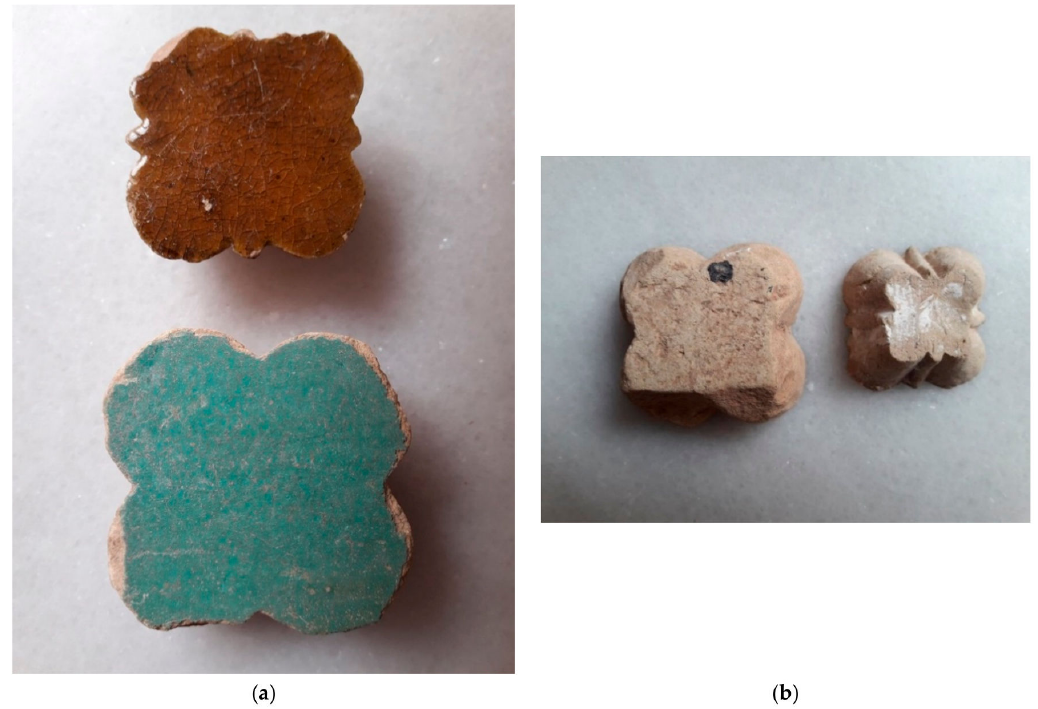
Figure 11. The front ( a ) and reverse ( b ) of alicatado pieces of unknown origin. © Private